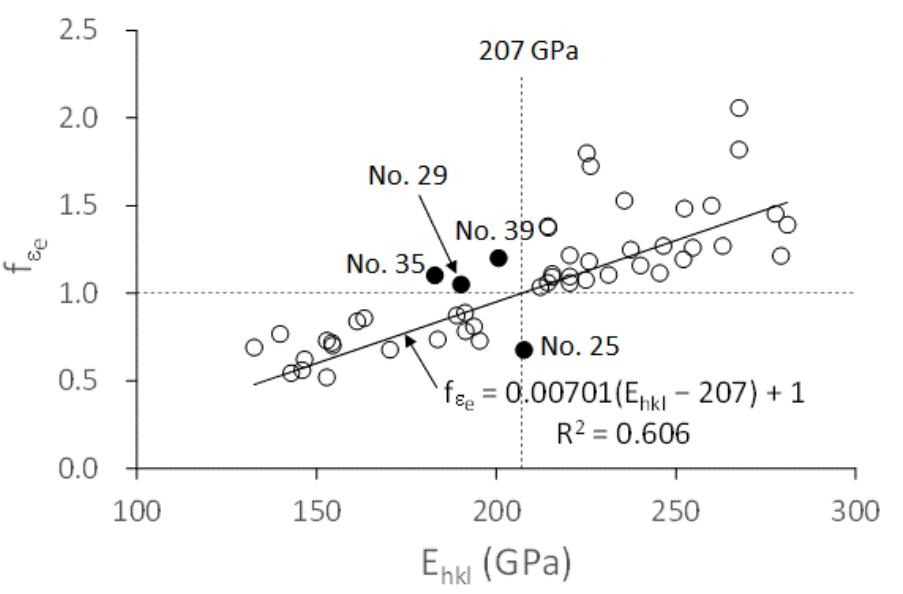
Figure 6. Elastic-strain ratio ( f ε e ) of individual grains in Table 1. Vertical line, the Young’s modulus of the bulk material.